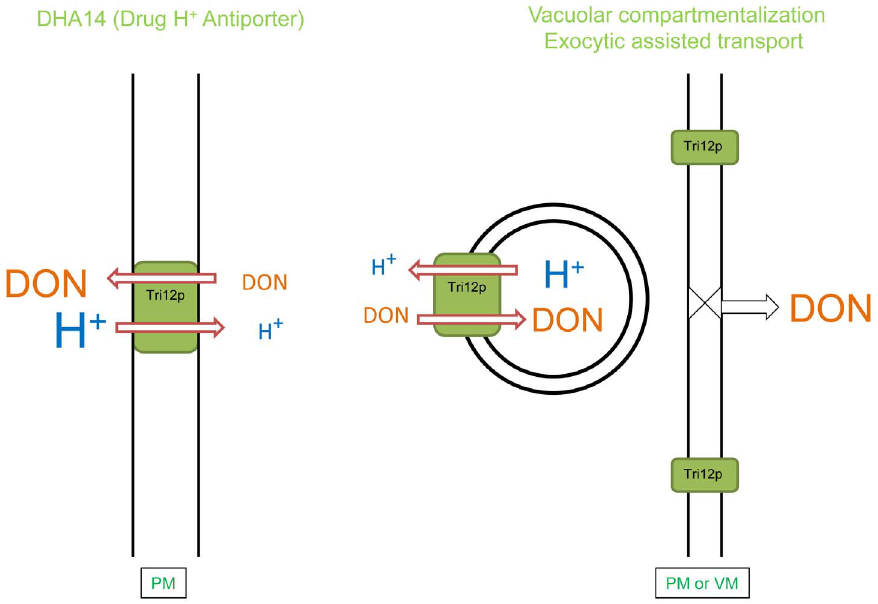
Figure 6. Models of Tri12p facilitated trichothecene export. (Left) Based on predicted amino acid sequence similarity, Tri12p corresponds to a DHA14 (Drug/H + antiporter with 14 membrane spanning domains) major facilitator transporter. Localization of Tri12p in the plasma membrane (PM) may directly lead to trichothecene (DON) export. (Right) Localization of Tri12p in the membrane of small motile vesicles may lead to accumulation of DON within. Upon fusion with the PM or the vacuolar membrane (VM), concentrated DON may be, respectively, eliminated by exocytosis or compartmentalized within the vacuole.